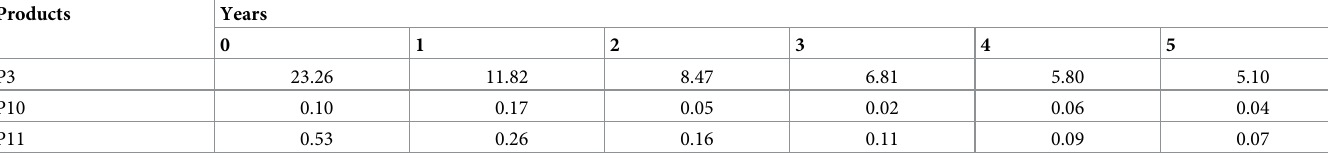
Table 11. Percentage of demand of special products over the total demand per years, in %.